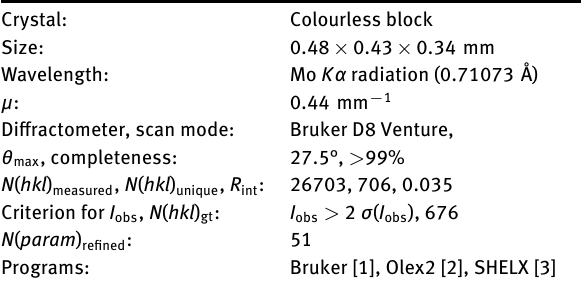
Table 1 contains crystallographic data and Table 2 contains the list of the atoms including atomic coordinates and dis- placement parameters. Table 1: Data collection and handling.